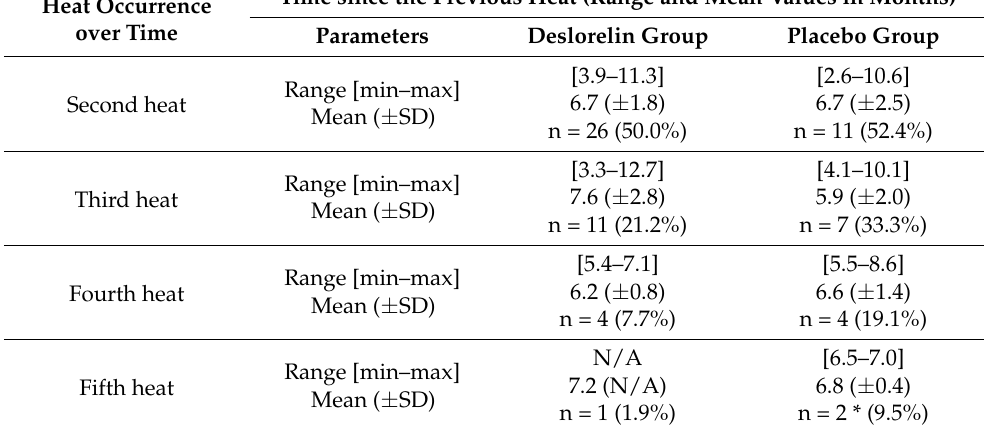
Table 1. Long-term (up to 24 months) qualitative observations of heat occurrence over time for the animals in the deslorelin and placebo groups, after the occurrence of the first oestrus. * Oestrus signs displayed 2–4 weeks outside of the 24-month observation period. SD = standard deviation. N/A = not applicable. n = number of animals (% within group).